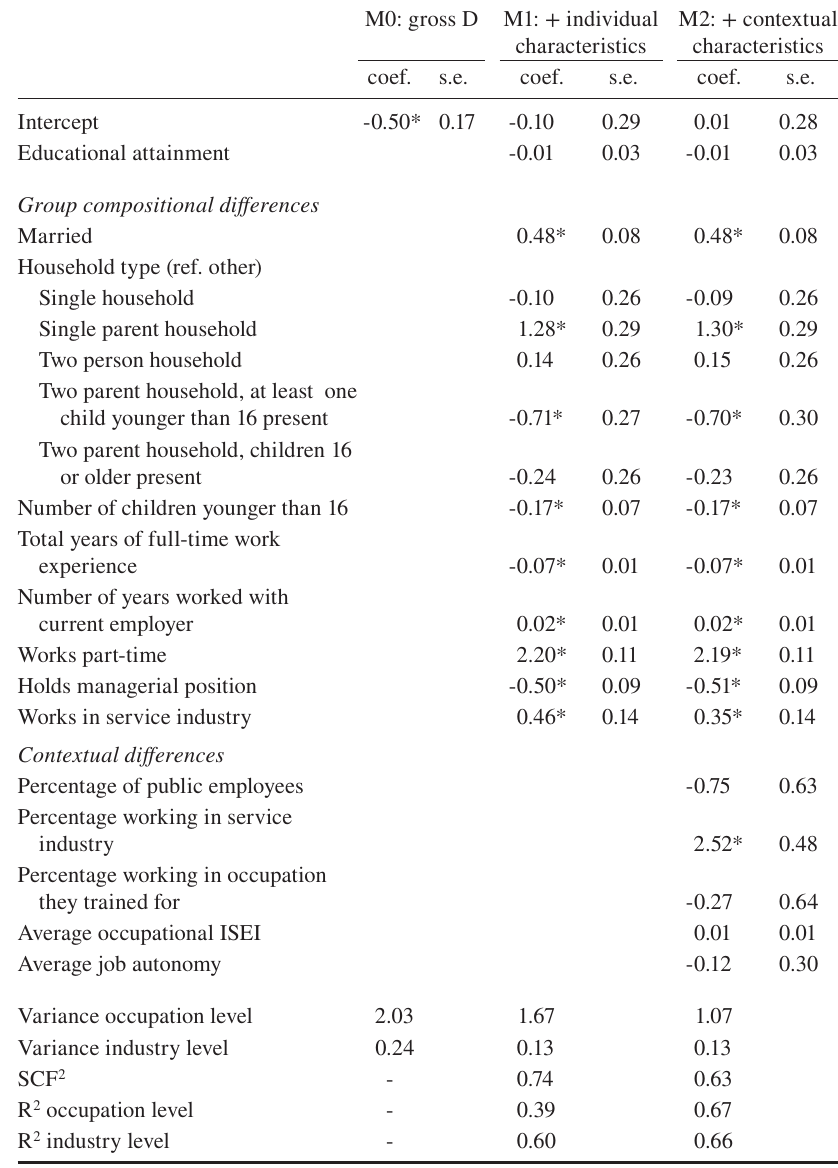
Multilevel modelling of occupational and industry gender segregation, GSOEP 2011